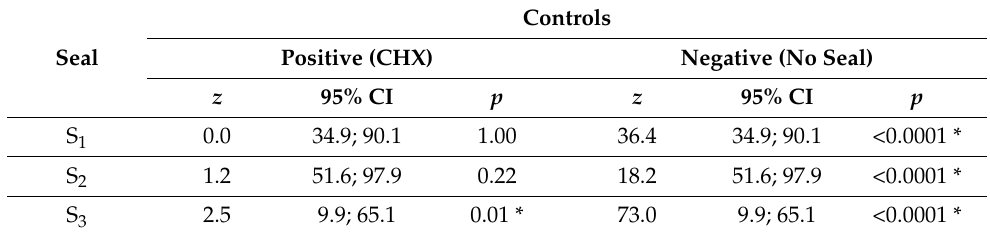
Table 2. Comparison between sealant materials and control groups with regard to Staphylococcus spp. infection.